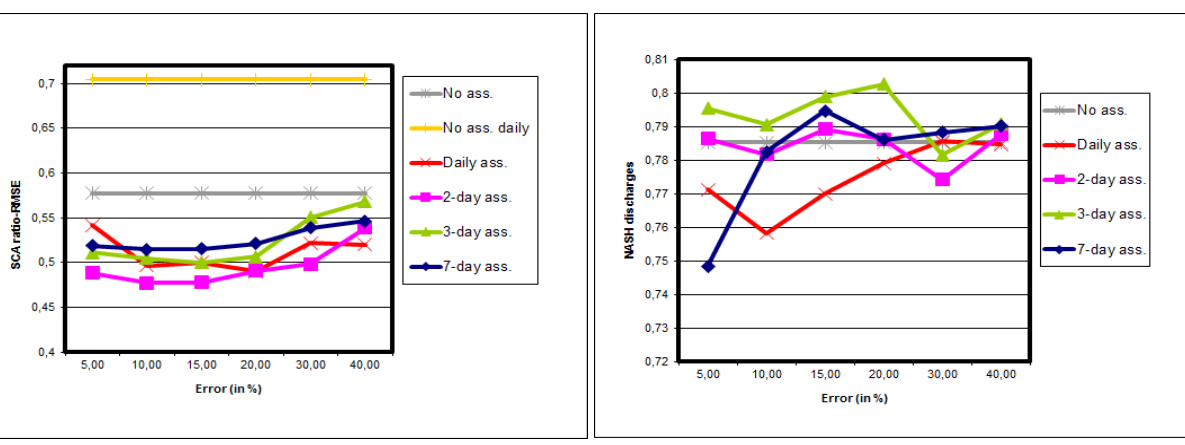
Figure 9. SCA ratio-RMSE ( left ) and Nash ( right ) for the real MODIS SCA particle filter experiments on the whole Morava basin with 50 particles. The SCA proxy (not plotted) has a ratio-RMSE of 0.52 compared with the composite MODIS and 0.55 compared with the daily MODIS; the proxy discharges have a Nash of